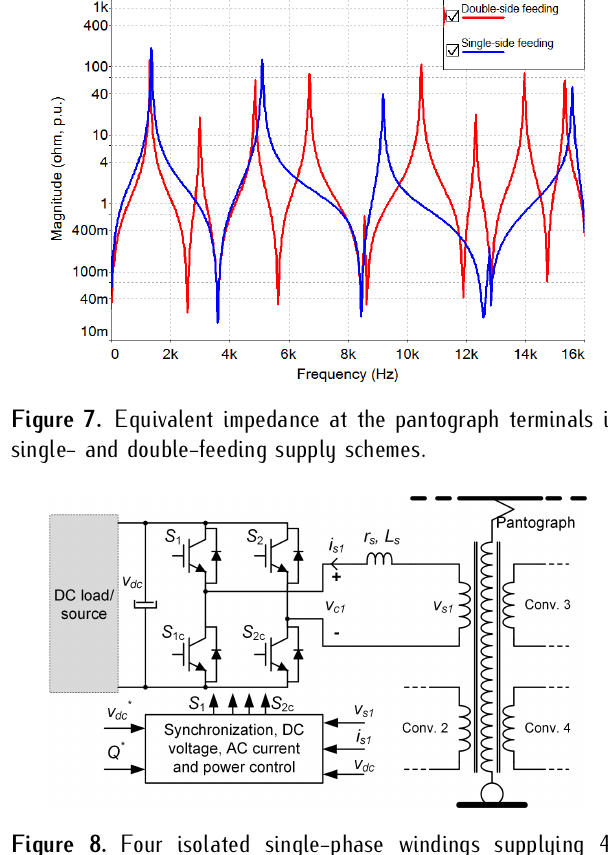
Figure 8. Four isolated single-phase windings supplying 4- quadrant converters operating in interleaved mode and main control requirements of each